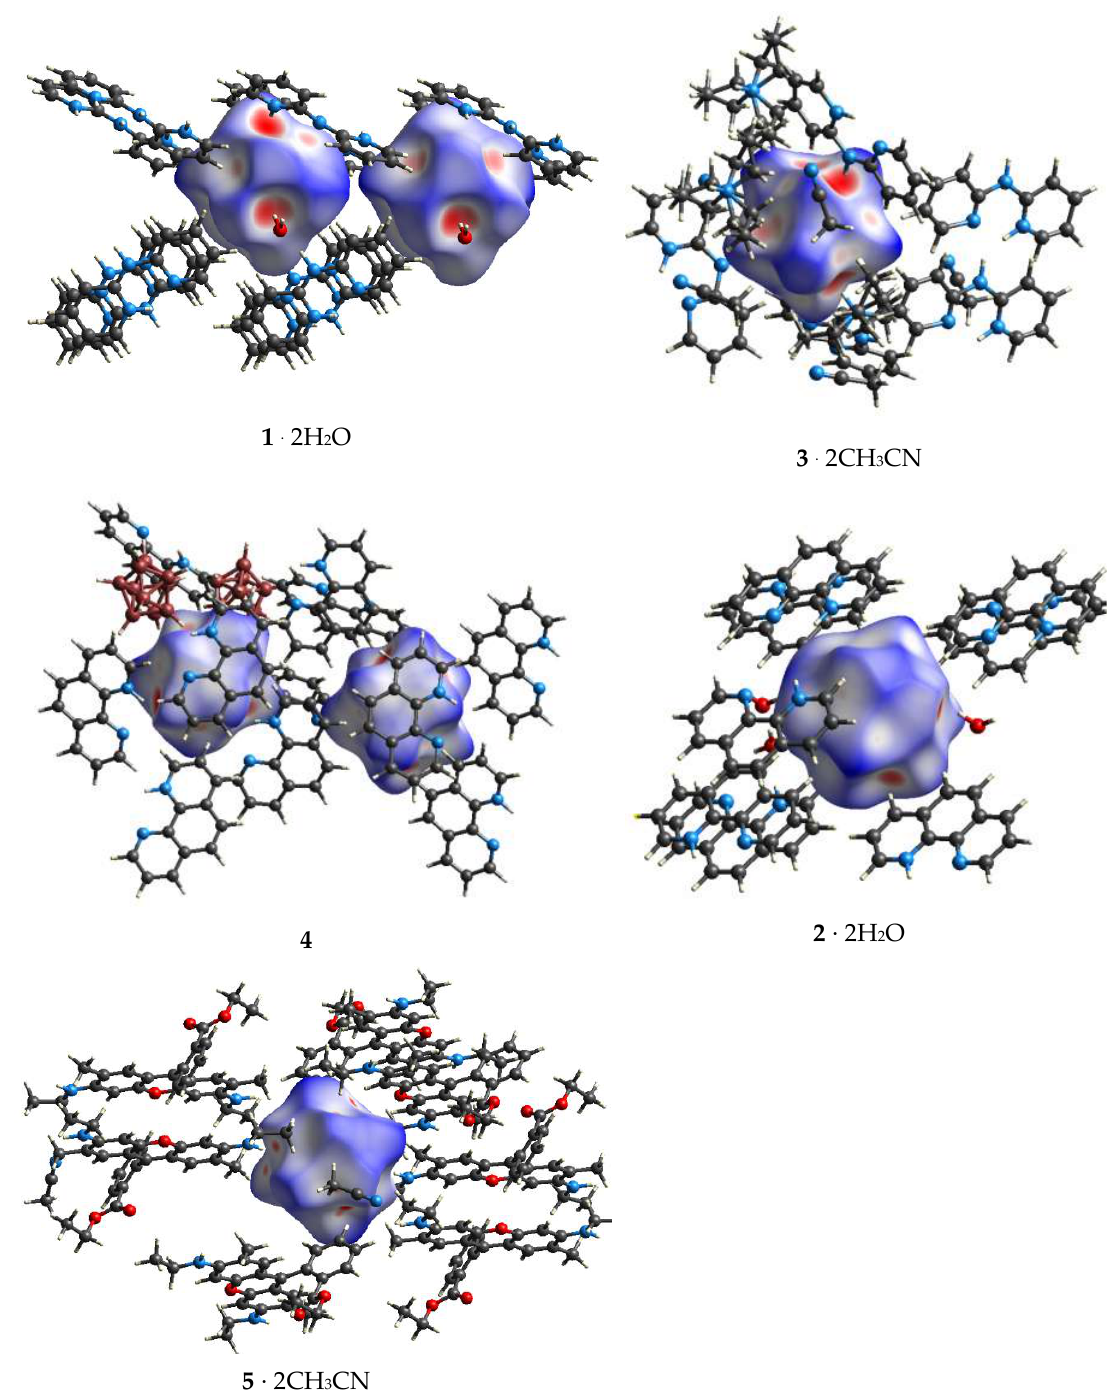
Figure 7. Molecular Hirshfeld surfaces of 1–5 mapped with d norm .